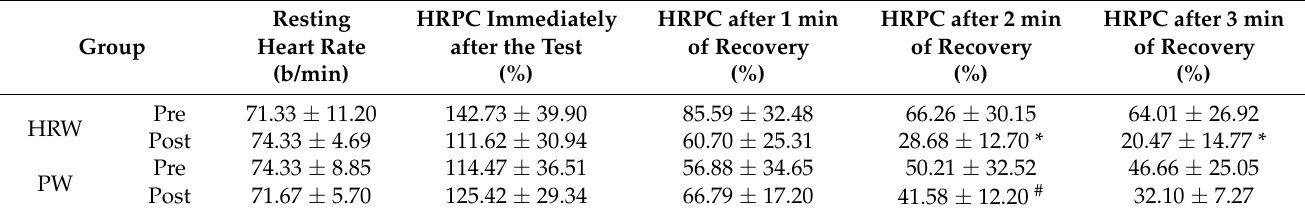
Table 4. Heart rate recovery before and after the intervention in the HRW and PW groups.